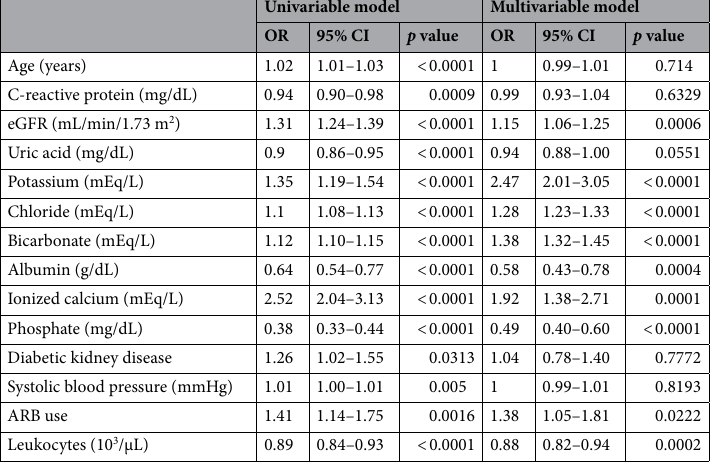
Table 4. Univariable and multivariable logistic regression models to identify the covariates associated with the non-high traditional AG value.